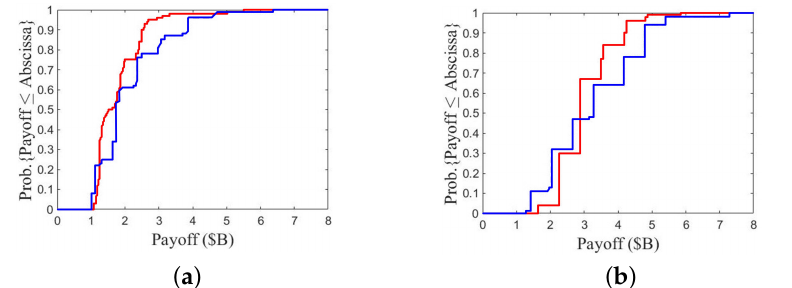
Figure 13. Cumulative distribution of payoff, ( a ) A3/B3, ( b ) A2/B2, with one P 2 SO run over 100 games, ———: fleet A, ———: fleet